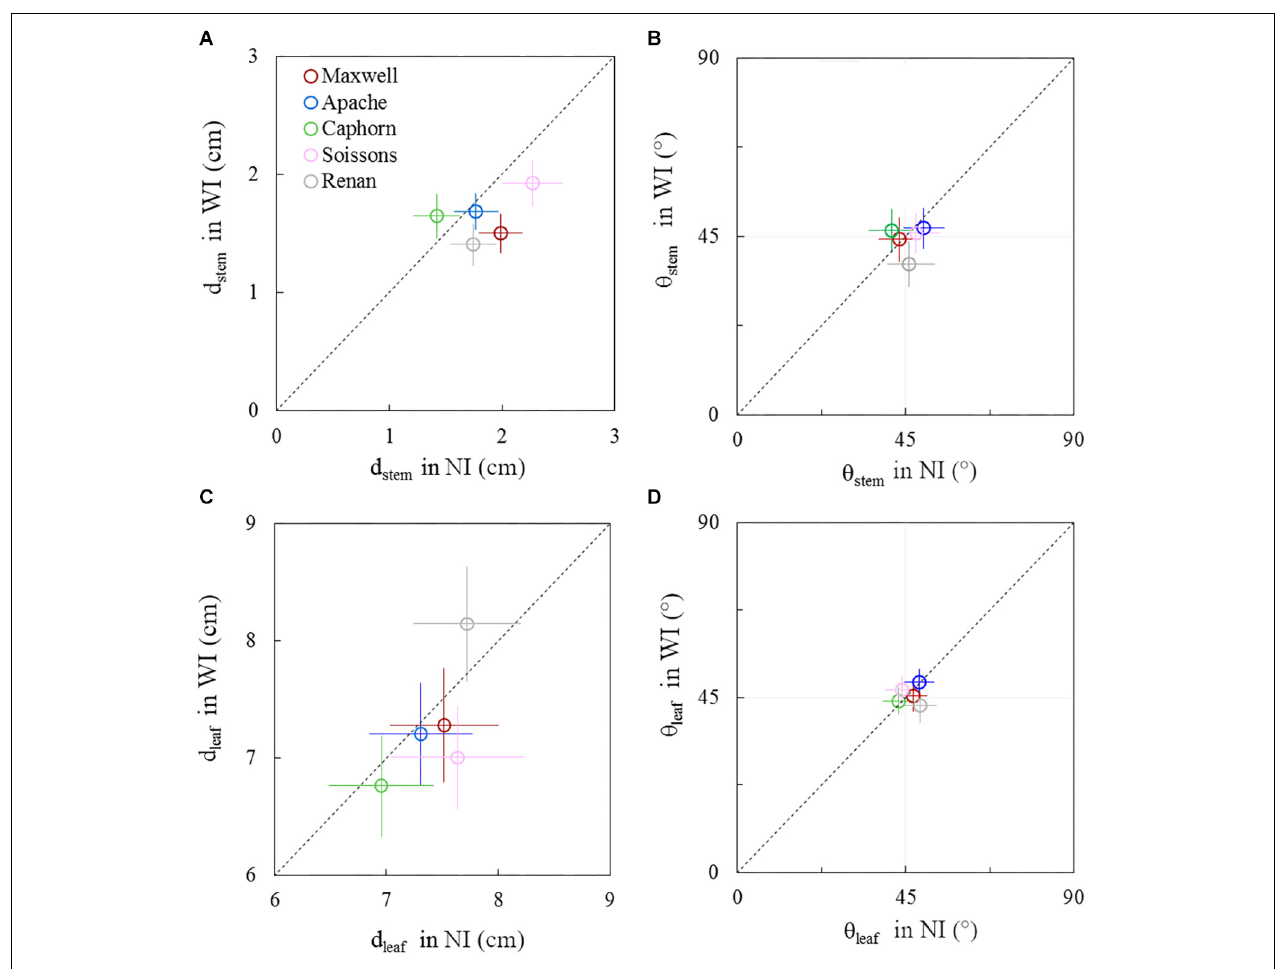
FIGURE 8 | Horizontal spacing and azimuth orientation of stems and leaves in WI treatments vs. NI treatments, at 722 ◦ Cd. The stem spread ( d stem ; A ), leaf spread ( d leaf ; C ), stem azimuth angle ( θ stem ; B ), and leaf azimuth angle ( θ leaf ; D ). Symbols represent the mean values taking into account all axes, for 30–60 plants per treatment. Error bars represent 95% confidence intervals of the mean estimates. The dotted line represents the line